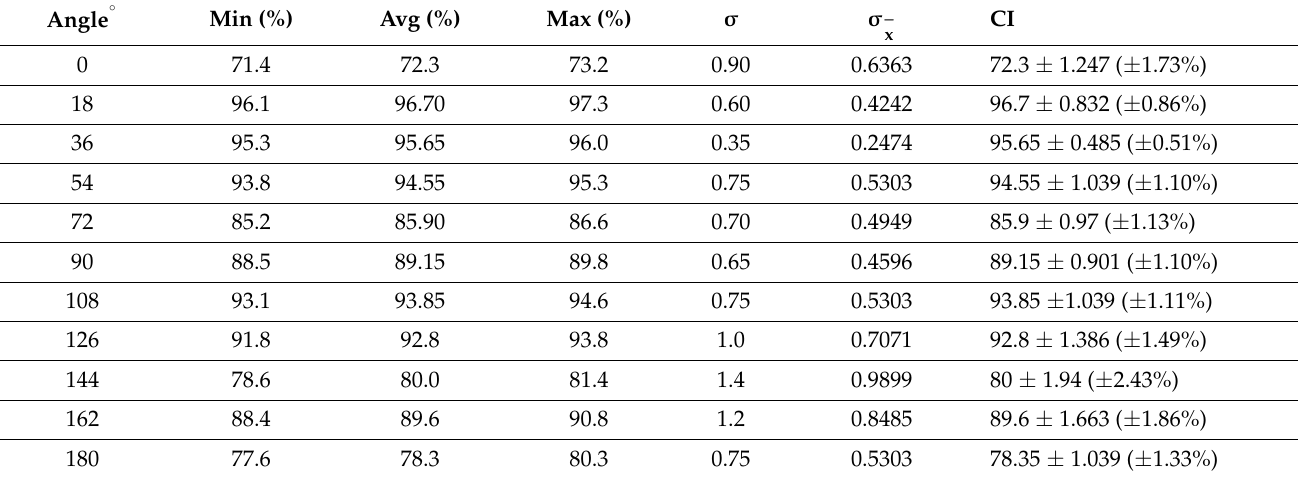
Table 9. Proposed gait recognition results using best-selected features fusion.